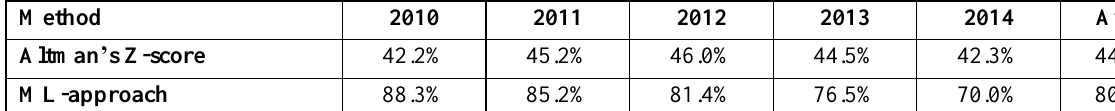
Table 8. Recall: Altman’s Z-score VS ML-approach